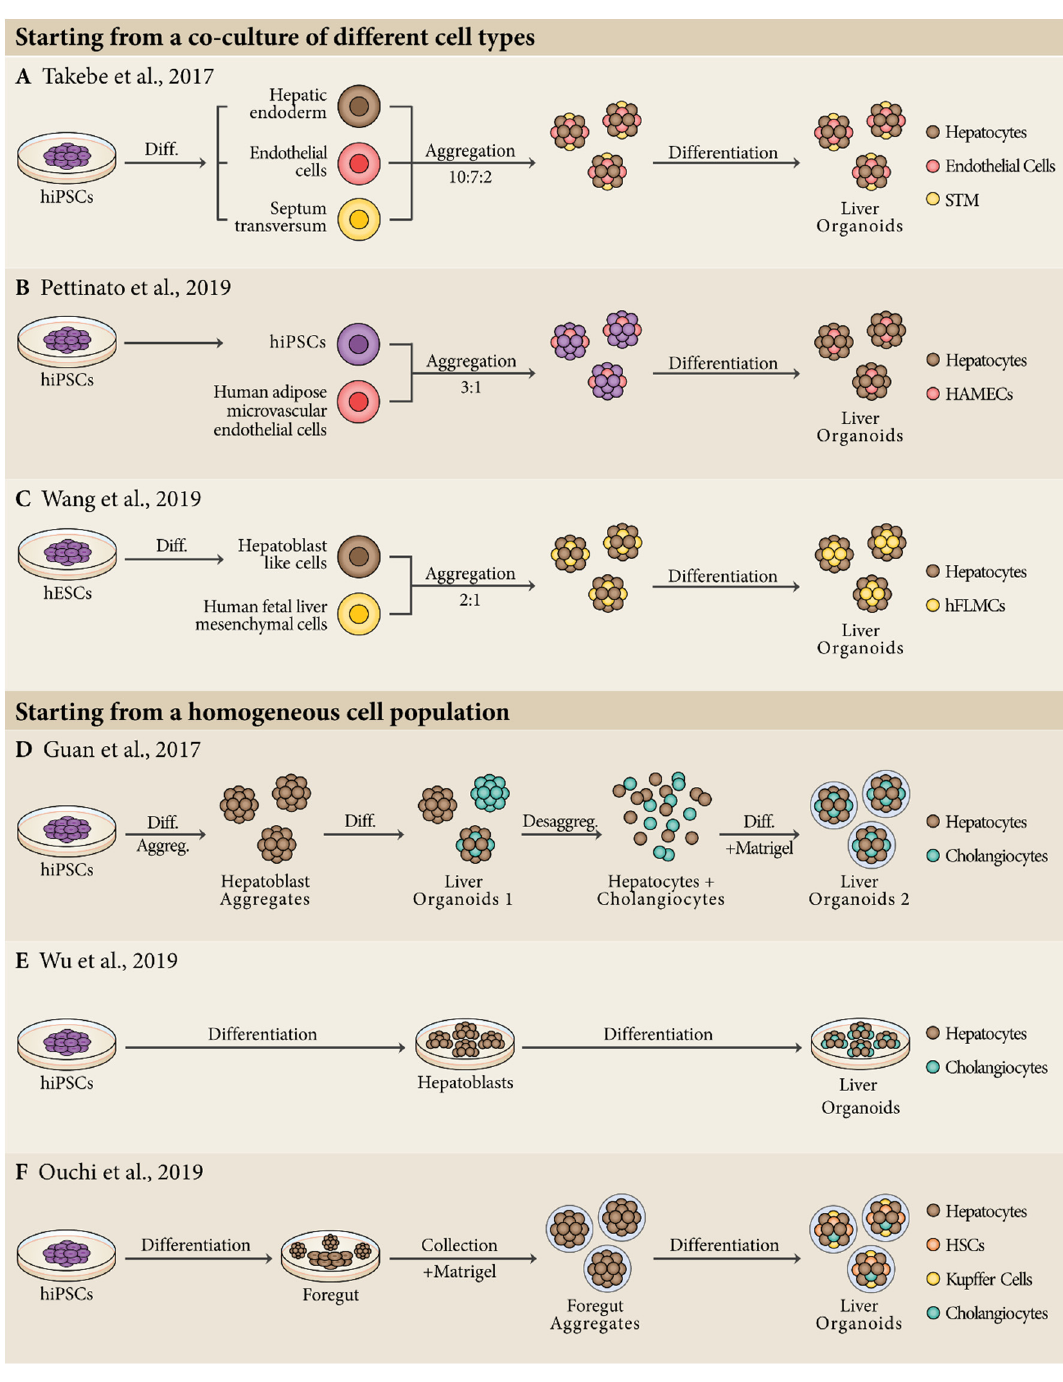
Figure 1. Current strategies for the generation of human pluripotent stem cell (hPSC)-derived liver organoids. So far, liver organoids have been generated by (A–C) co-culture of different cell types, including hPSCs, differentiated hepatic cell lineages, or isolated human cells with potential to promote liver organoid differentiation/maturation; (D–F) homogeneous cell populations that, through differentiation, are capable of generating cellular constructs with structural and physiological complexity. STM, septum transversum mesenchymal cells; HSCs, hepatic stellate cells.